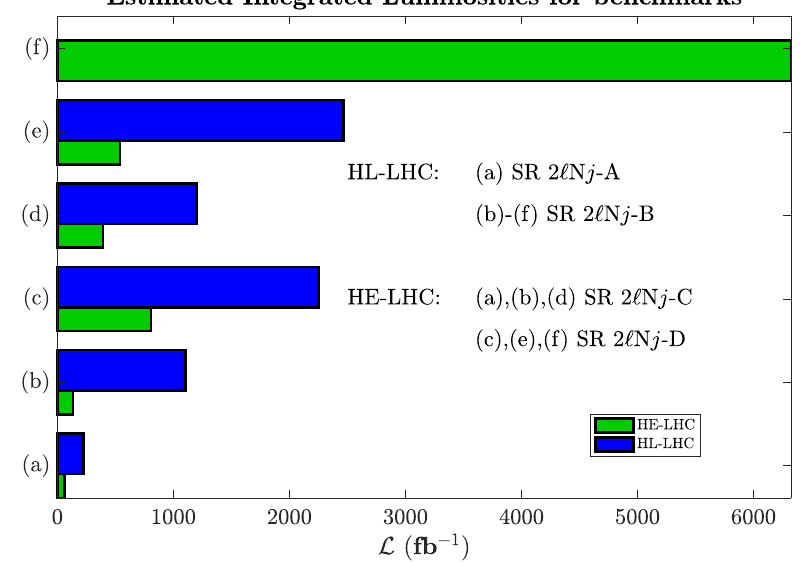
Figure 5 . Estimated integrated luminosity for discovery of benchmarks (a)–(f) at HL-LHC and HE-LHC. All points except (f) are visible at HL-LHC while all points are discoverable at